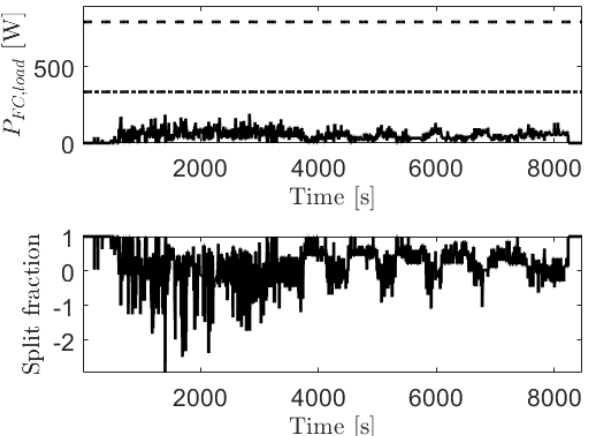
Figure 17. Fuel cell load demand power and split fraction versus time, Simulation Scenario III. The dashed and dashed-dotted lines in the top figure indicate the maximum P FC with γ and = 20 deg, respectively. | |